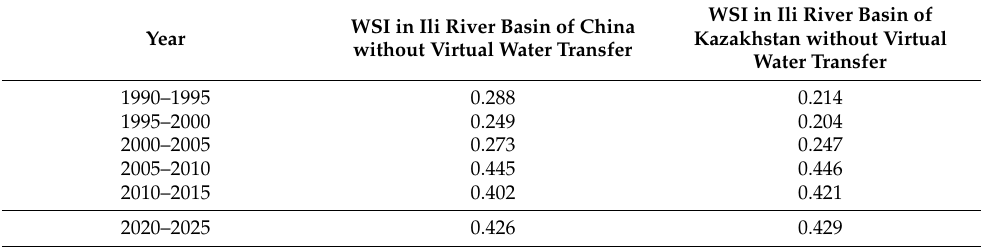
Table 3. WSI of the study area without virtual water